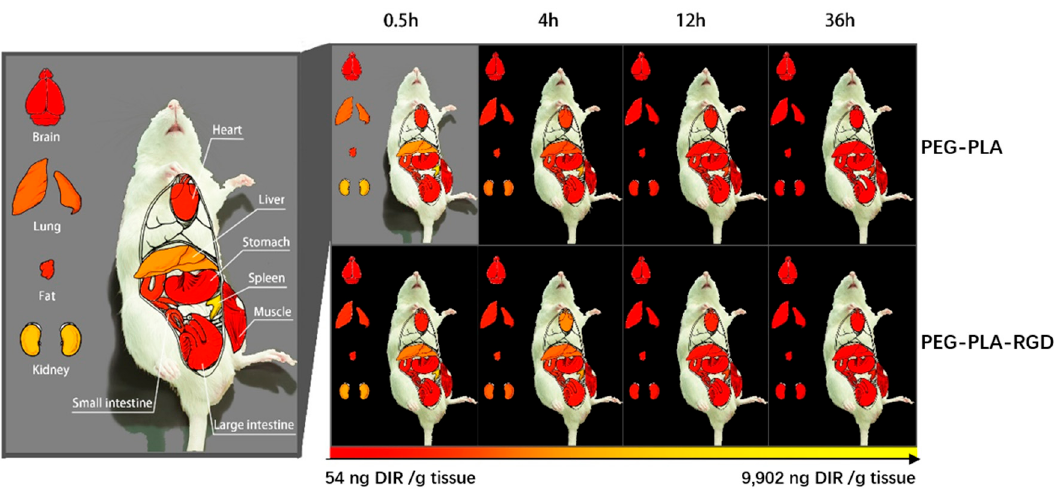
Figure 3. The specific biodistribution of nanoparticles in rats, the distribution of non-targeted PEG- PLA/1,1-dioctadecyl-3,3,3,3-tetramethylindotricarbocyaine iodide (DIR) and RGD-PEG-PLA/DIR nanoparticles varies by organs and tissues.